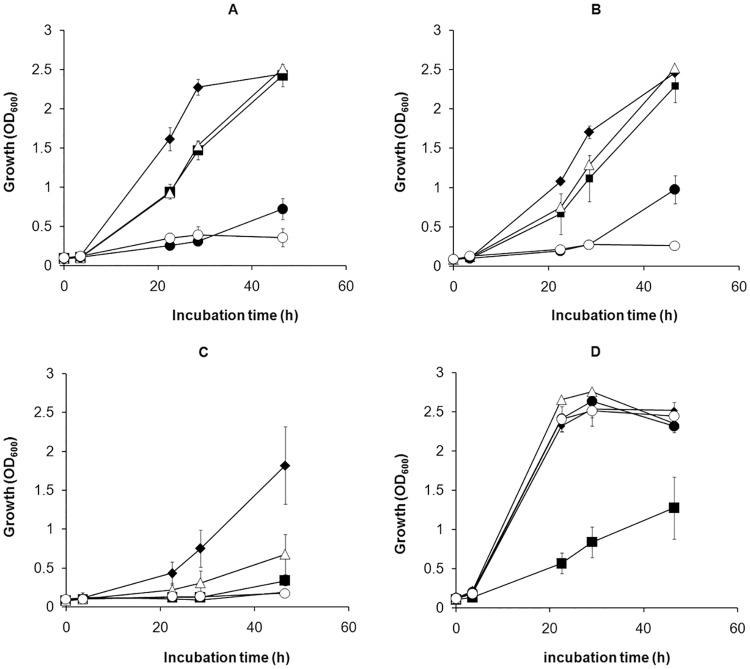
Growth of SCHU S4 (filled diamonds), ΔfeoB (filled squares), ΔfslA (open triangles), ∆fupA (filled circles) and ΔfslA/∆fupA (open circles) in C-CDM supplemented with heme A) 150 μM B) 75 μM and C) 20 μM or FeSO4 D) 26 μM.All strains were iron depleted prior to the assay.